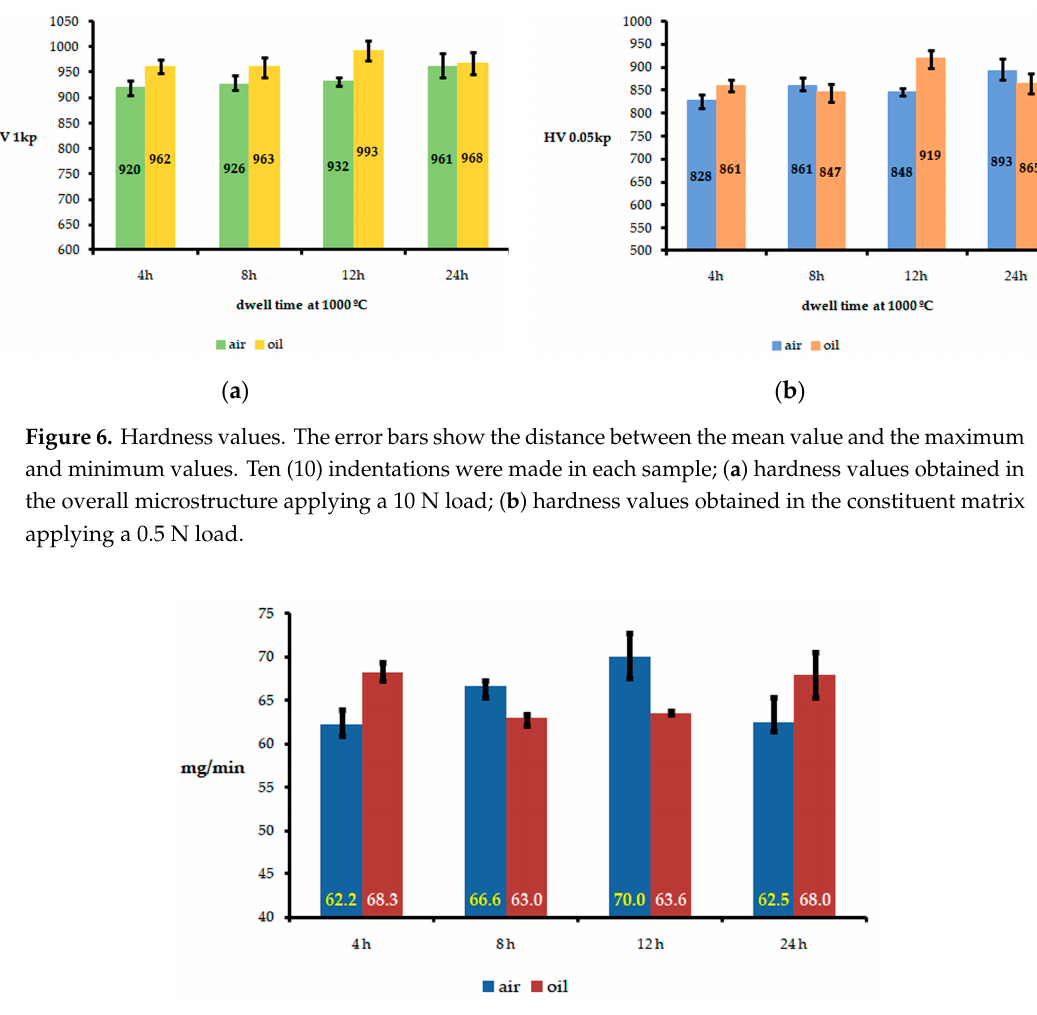
Figure 6. Hardness values. The error bars show the distance between the mean value and the maximum and minimum values. Ten (10) indentations were made in each sample; ( a ) hardness values obtained in the overall microstructure applying a 10 N load; ( b ) hardness values obtained in the constituent matrix applying a 0.5 N load.